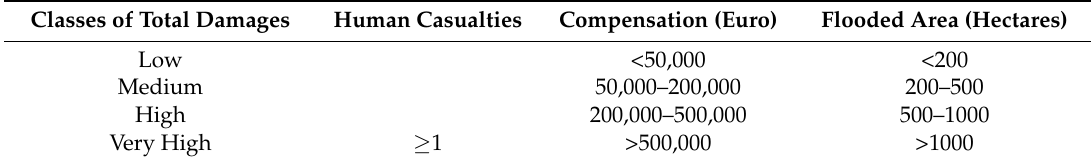
Table 1. Categories of the total damages, amount of monetary compensation and flooded area of the historical flood